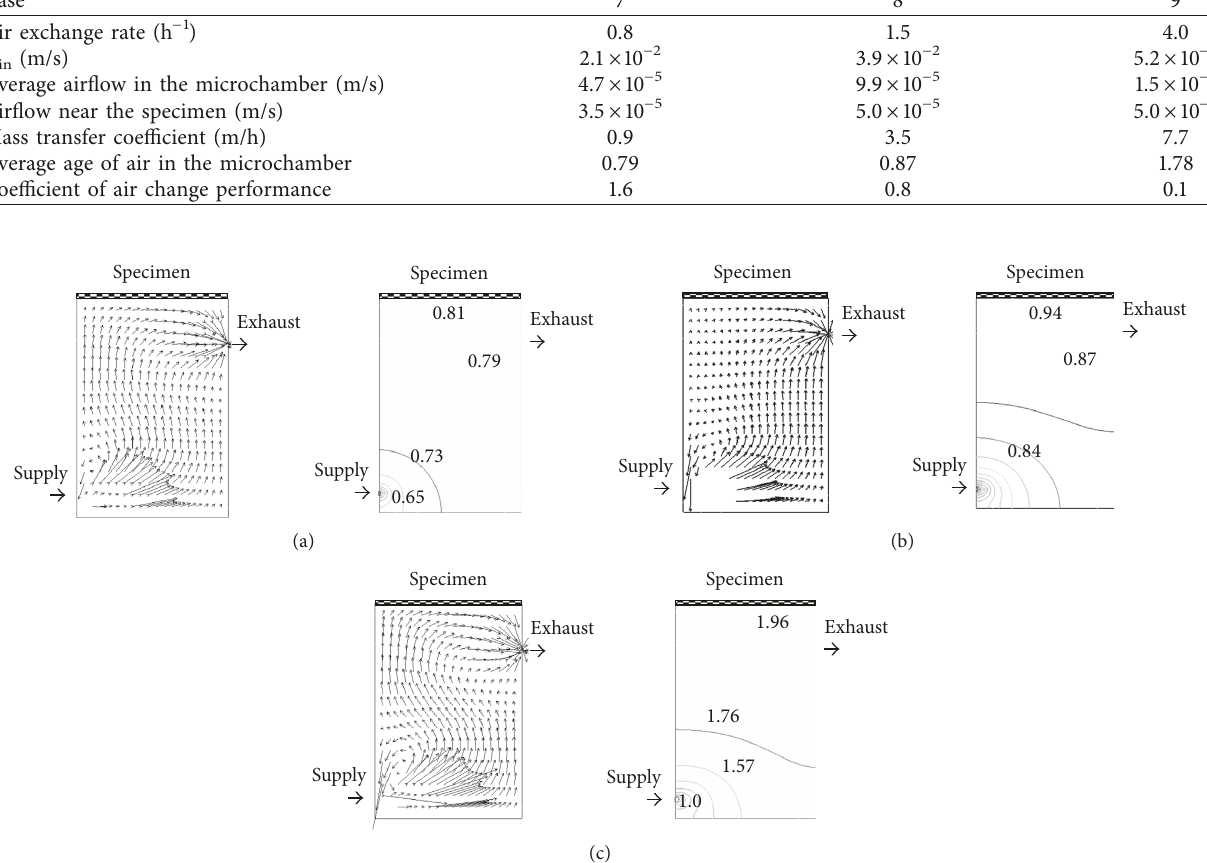
Table 7: CFD analysis results (air exchange rate